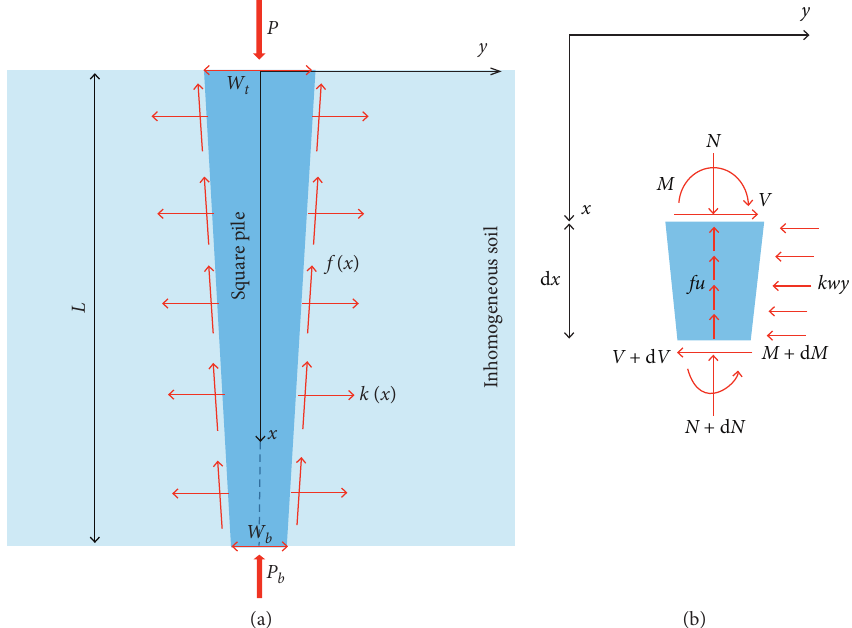
Figure 1: Schematics: (a) tapered friction piles in inhomogeneous soils with linear shaft friction and linear lateral stiffness; (b) free-body